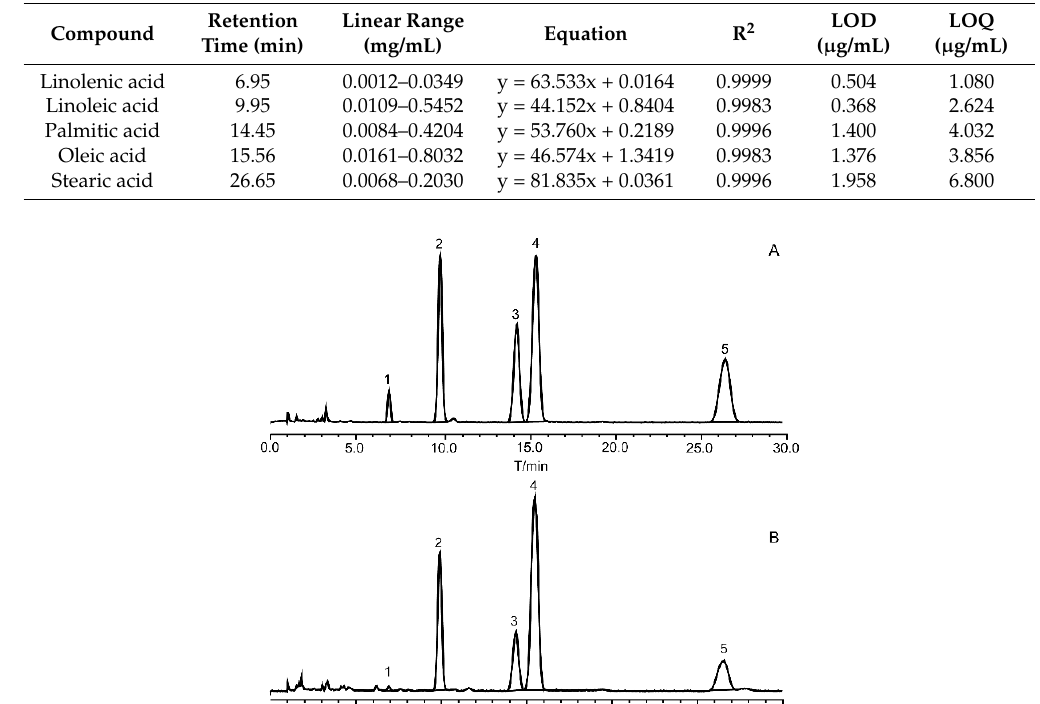
Table 1. Linearity, LOD, and LOQ of the investigated compounds.